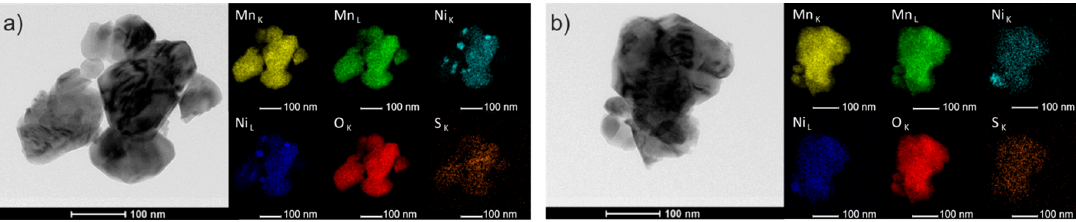
Figure 2. Transmission electron microscopy images and elemental mapping of ( a ) LMN5OS sample; and ( b ) LMN1OS.